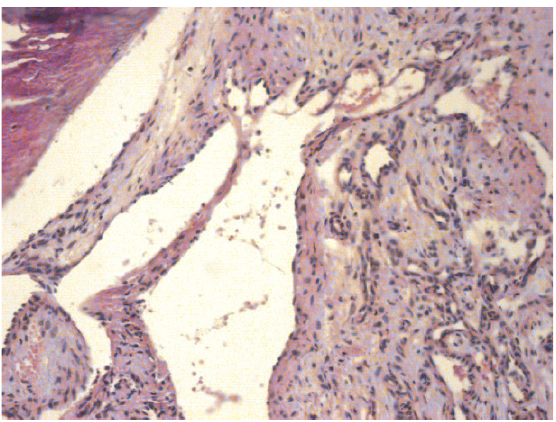
Figure 2. Microscopic section, cavernous hemangioma. Fragment of the bone in the right corner (HE stain, original magnification